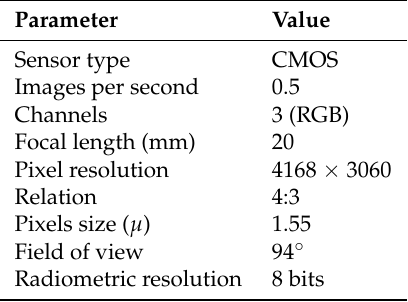
Table 2. Technical specifications of the UAV camera used for image